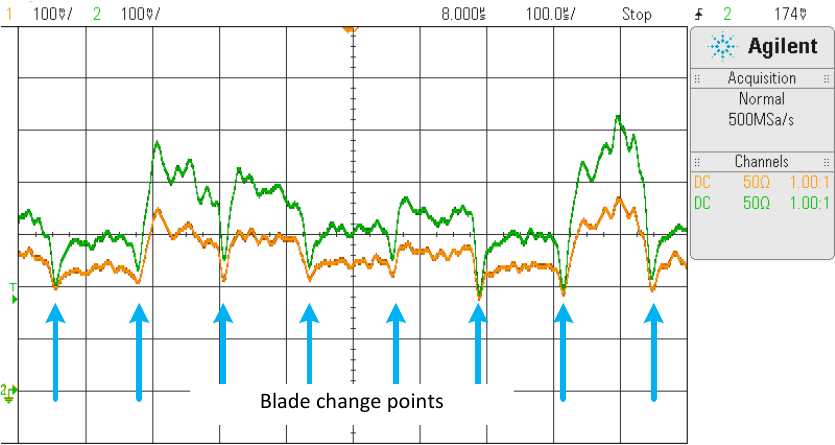
Figure 3. V 1 (orange) and V 2 (green) signals captured for seven blades.